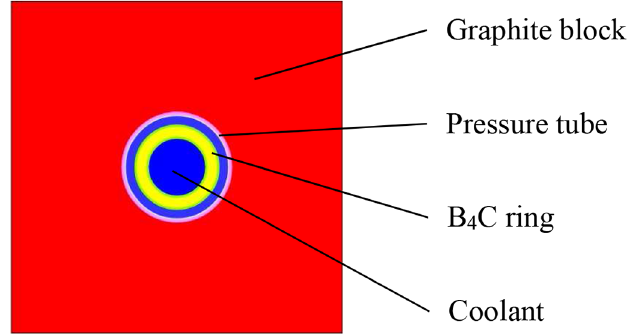
Fig. 4. Sectional view of CPS with the absorber.